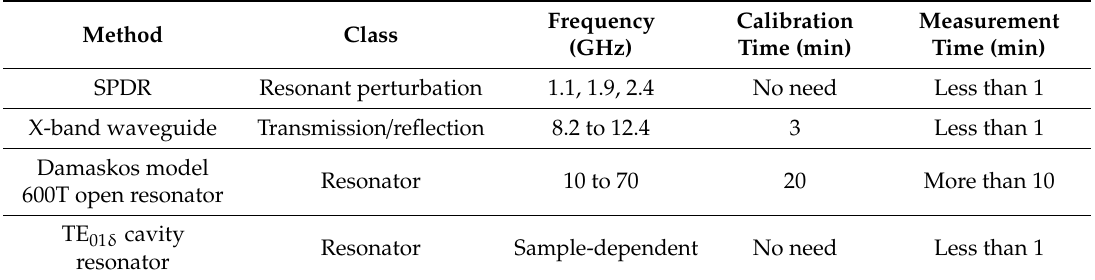
Table 3. Comparison of SPDR, X-band waveguide, Damaskos Model 600T open resonator, and TE 01 δ mode cavity